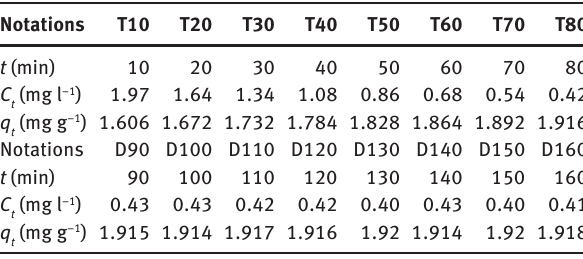
Table 3: The amount of fluoride adsorbed onto RHA/Al(OH) different